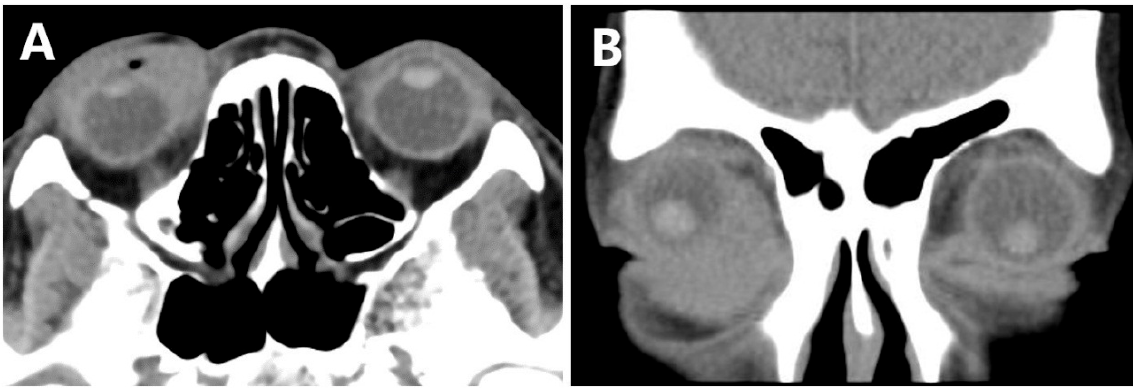
Figure 2. CT scan of the orbits. The mass was located in the right medial orbital, and there was no sign of nasal infiltration. Equal to soft tissue density. ( A ) Horizontal view. ( B ) Coronal view.